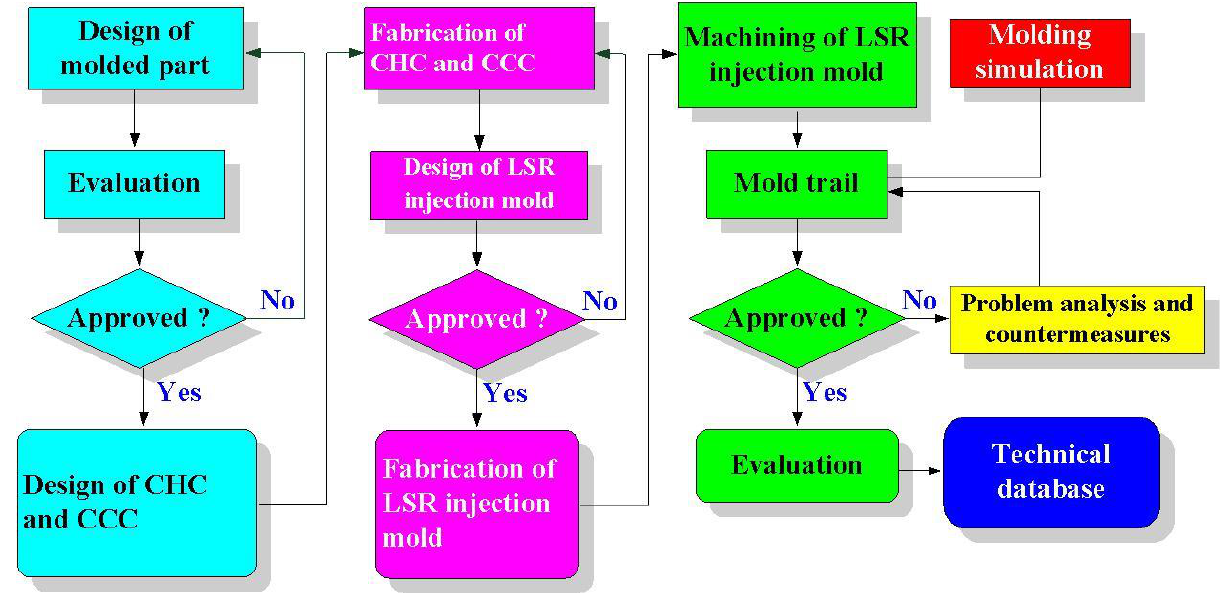
Figure 1. Flow diagram of the experimental methodology.